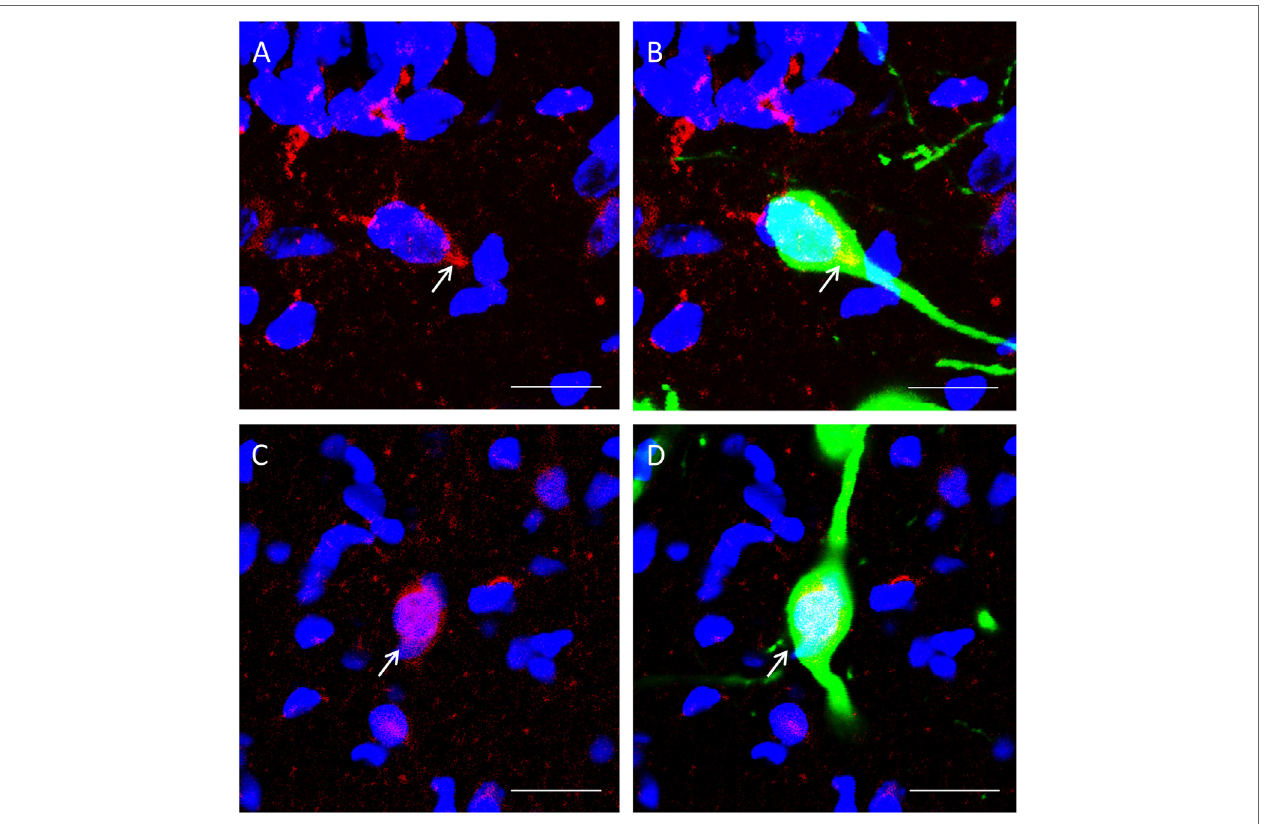
FigUre 4 | The colocalization of β -catenin immunostaining with DAPI within gonadotropin-inhibitory hormone (GnIH) neurons in the dorsomedial hypothalamus (DMH) region. (a) β -catenin immunostaining (red) and DAPI cytoplasmic staining (blue) and (B) colocalization with GnIH neuron (green). (c) β -catenin immunostaining (red) in the cytoplasm with DAPI nuclear staining (blue) and (D) colocalization with GnIH neuron (green). Scale bar = 20 µm. White arrows indicate the presence of β -catenin colocalization with GnIH